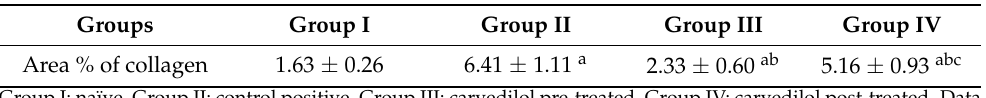
Table 3. Effect of carvedilol on % area of collagen fibers in liver sections of different groups in hepatic ischemia associated with isoprenaline-induced AHF .